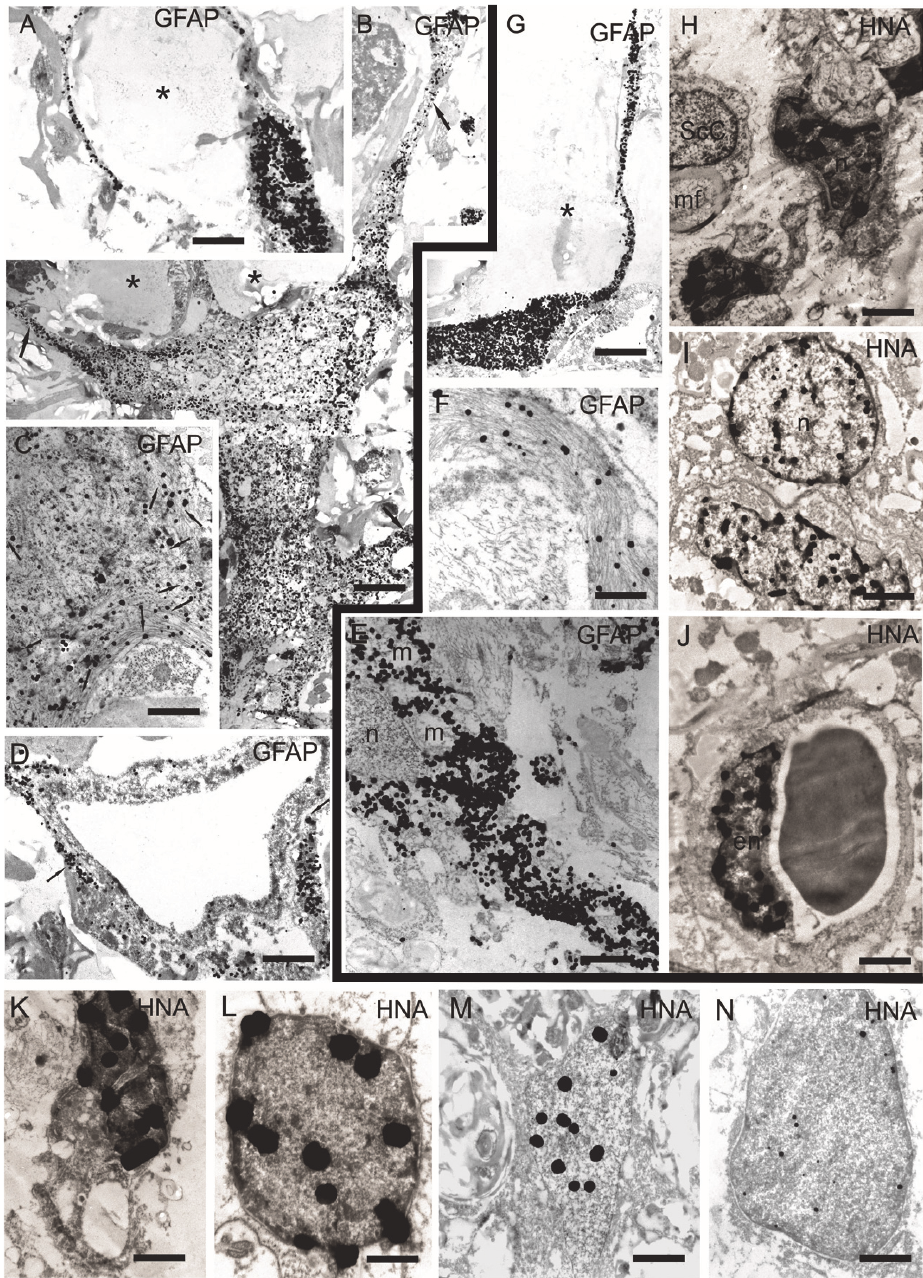
Figure5:Immunoelectronmicroscopicresults.( 0 –D),(K–N)ImmunohistochemicalreactionintheareaofspinalcordinjuryinhUCB-MCs + Ad5-VEGF + Ad5-GDNF group. (A) GFAP-positive astrocyte with narrow processes which limit small posttraumatic cavity (asterisk). (B) GFAP-positive fibrous astrocyte with numerous branched processes (arrows), which surround the cavity (asterisks) and form myelinated and unmyelinated fibers. ( b ) Cytoplasm of GFAP-positive fibrous astrocyte. Colloidal gold particles sit exclusively on intermediate filaments in the cytoplasm of cells (arrows). (D) GFAP-positive reaction (arrows) around the capillaries. (K) HNA-positive reaction in microglia nucleus. (L) HNA-positive cells with round nucleus and narrow rim of cytoplasm. (M) HNA-positive reaction in fibrous astrocyte nucleus. (N) HNA- positive reaction in elongated cell nucleus in the area of injury. (E–J) Immunohistochemical reaction in the area of spinal cord injury in hUCB-MCs group. ( @ ) GFAP-positive fibrous astrocyte. (F) GFAP-positive intermediate filaments in fibrous astrocyte cytoplasm. (G) GFAP- positive narrow astrocyte with thin processes. (H) HNA-positive reaction in microglia nucleus. (I) HNA-positive elongated cell with oval nucleus and oval cells with a round nucleus. (J) HNA-positive endothelial cell. Scale bar: 5 𝜇 W (A, D, G, J), 1 𝜇 W (B, N, E, I), 200 nm (C), 500 nm (K), 300 nm (L, F), 700 nm (M), and 800 nm (H). n: nucleus; mf: myelin fiber; m: mitochondria; en: endothelial cell; ScC: Schwann